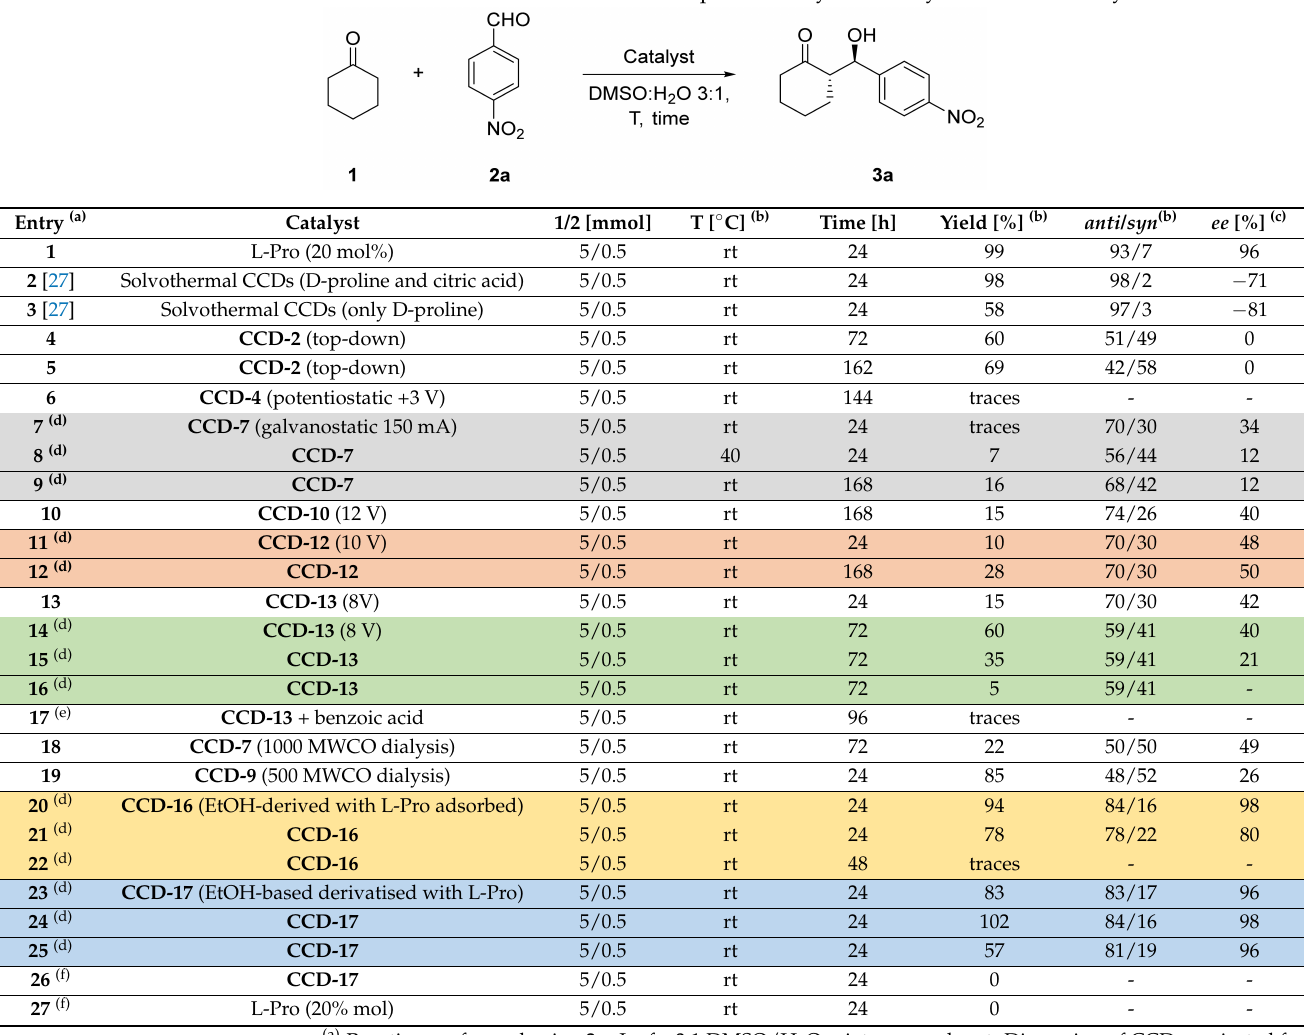
Table 3. Stereoselective aldol reaction promoted by differently electrochemical synthesised CCDs.